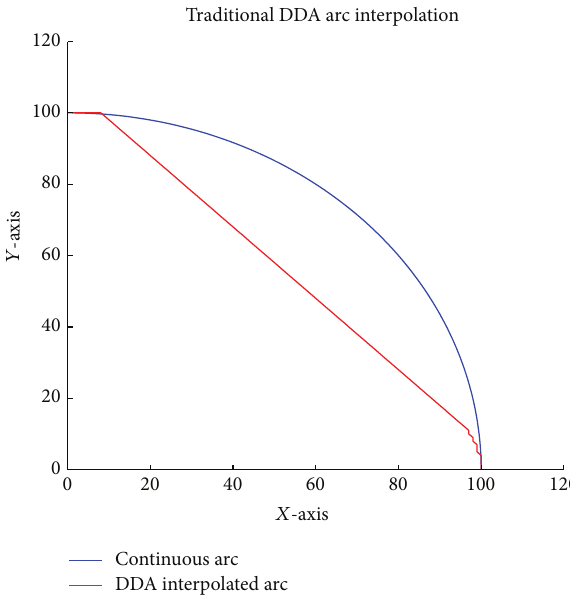
Figure 6: Huge errors of traditional DDA algorithm.